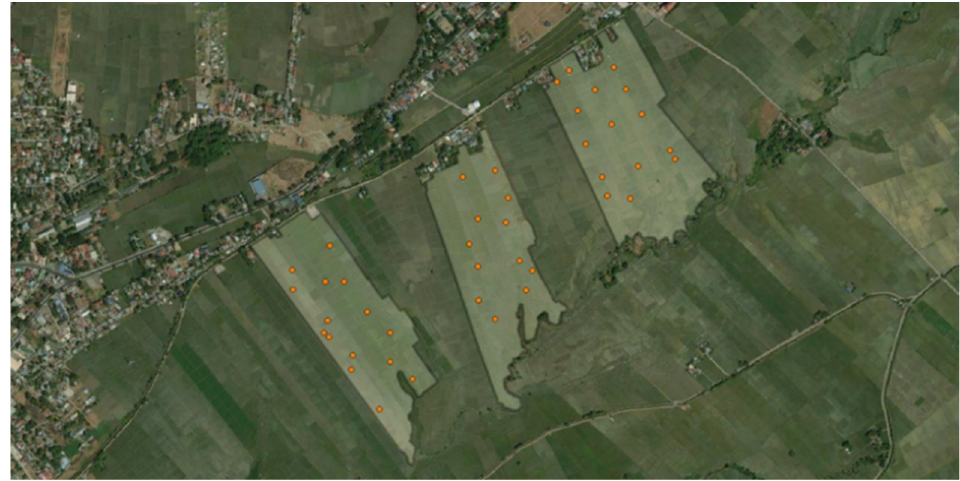
Figure 2. Turnout service area showing the observation well installed in each plot .